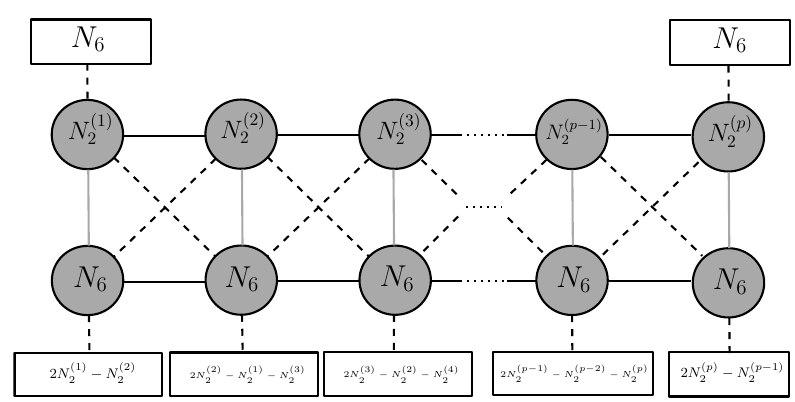
Figure 4 . Generic quiver field theory associated to D2-D4-NS5-D6 brane